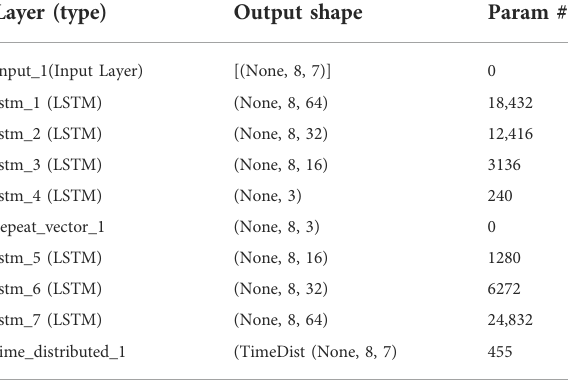
TABLE 2 LSTM-SDAE model and its